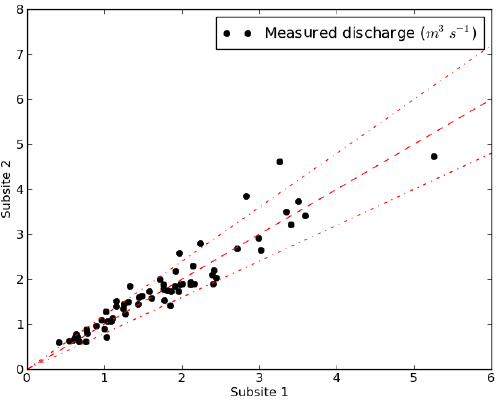
Fig. 6. Comparison between discharge measured at sites 1-1 and 1- 2 on the Urumqi River during the summer of 2006. The dashed line corresponds to perfect agreement and the dotted lines correspond to a 20% uncertainty